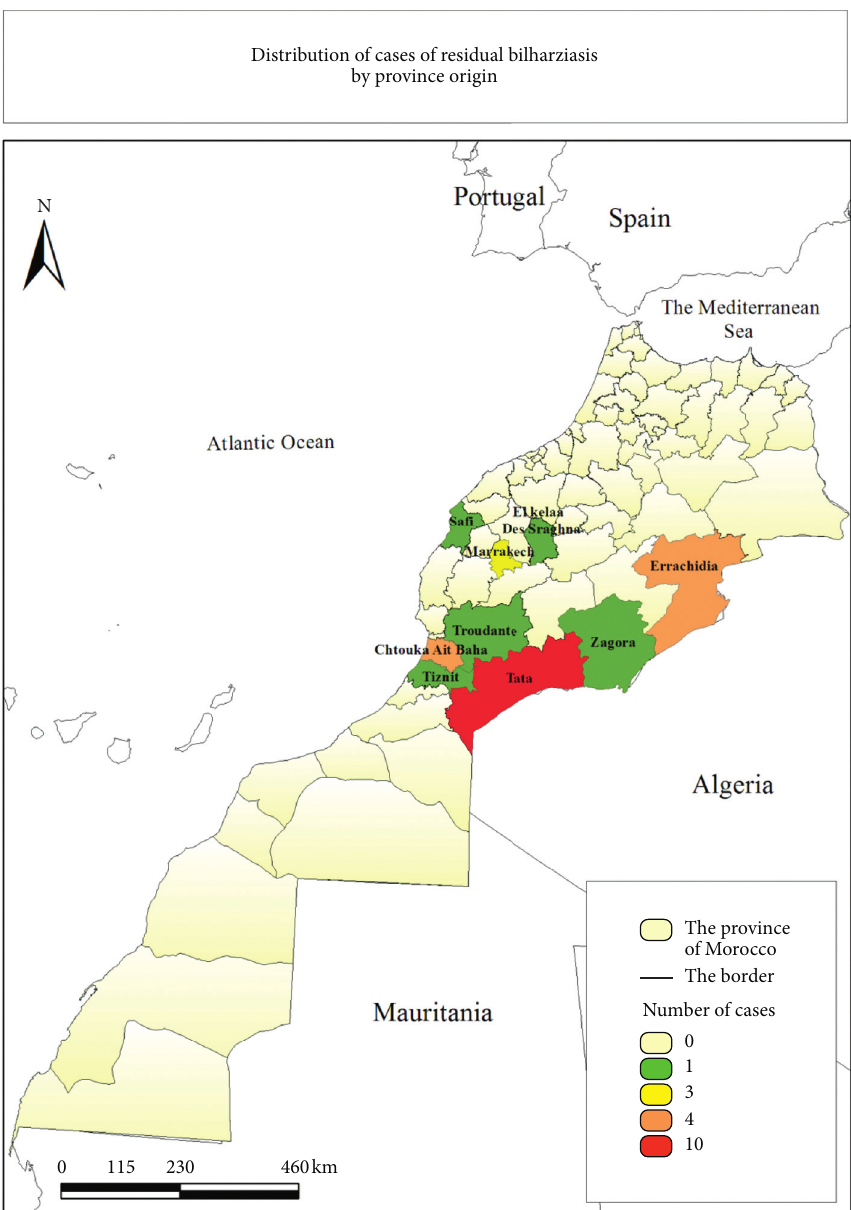
Figure 4: Distribution of residual cases of bilharziasis in Morocco: